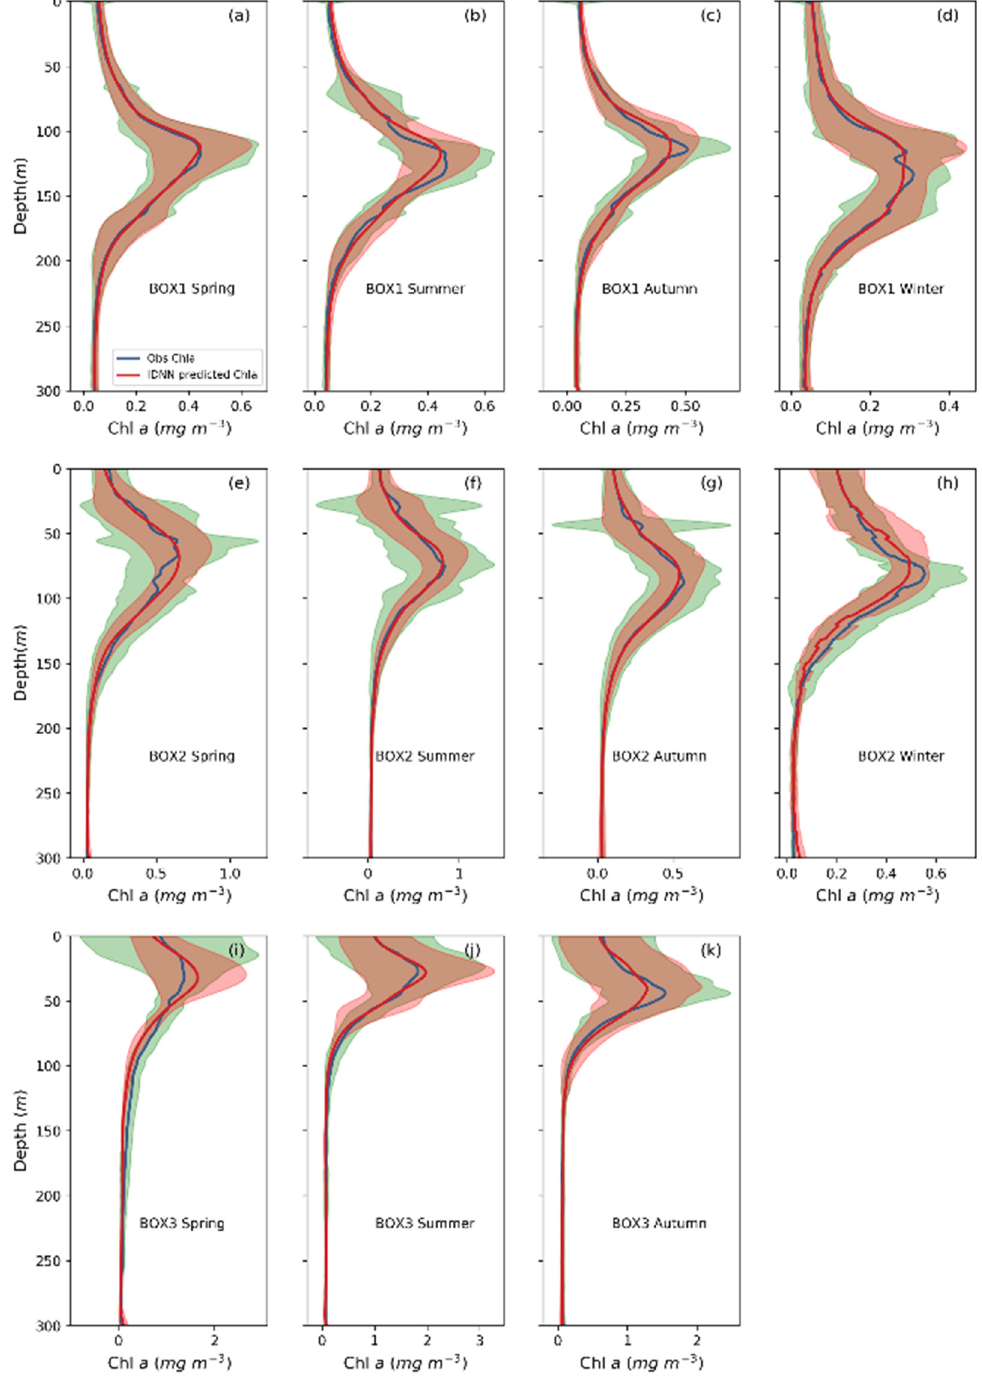
Figure 5. Aggregated chlorophyll vertical profiles from the test set in terms of seasons in BOX1 ( a–d ), in BOX2 ( e–h ), and in BOX3 ( i–k ). The blue and red solid lines represent the mean of observed value and the mean of IDNN predicted Chl a , respectively. The pink and green shades are the standard variance of the model results and observations, respectively, which overlap and form the brown shade.